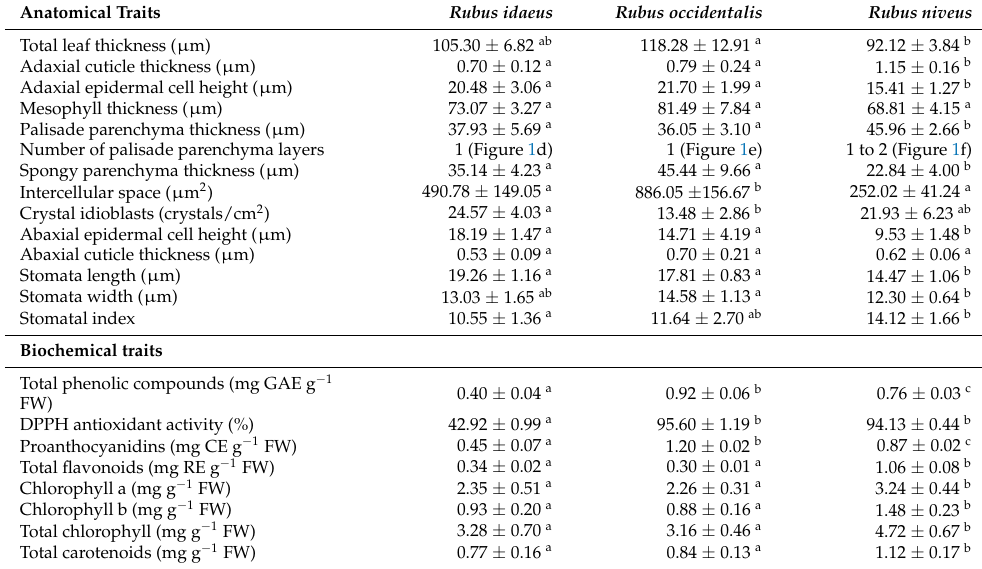
Table 1. Anatomical and biochemical traits of Rubus idaeus cv. Autumn Bliss, R. occidentalis and R. niveus . Statistically different ( p < 0.05) values are denoted by lowercase letters within rows according to a one-way ANOVA followed by Tukey’s post-hoc